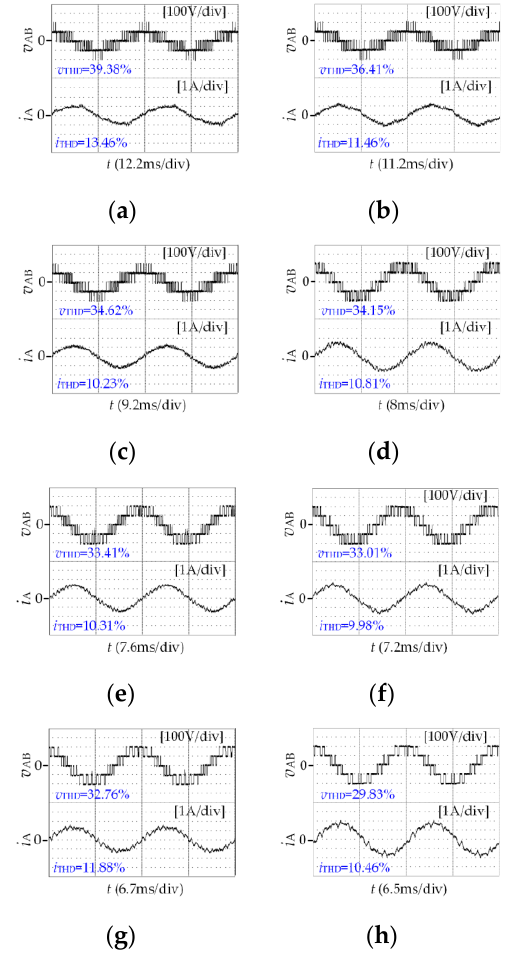
Figure 13. Experimental results of v THD and i THD . ( a ) m = 0.51, P = 15(IV). ( b ) m = 0.56, P = 15(I). ( c ) m = 0.68, P = 13. ( d ) m = 0.78, P = 11(IV). ( e ) m = 0.82, P = 11(I). ( f ) m = 0.86, P = 9. ( g ) m = 0.93, P = 7. ( h ) m = 0.96, P = 5.